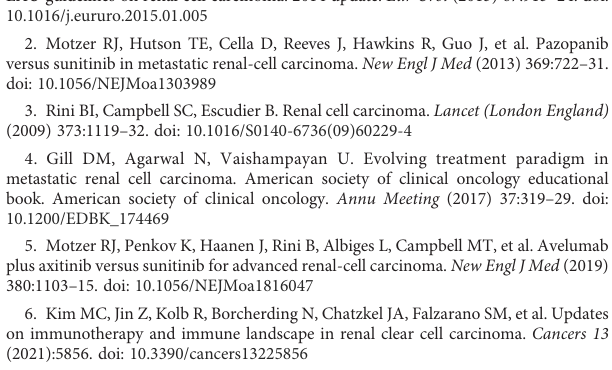
SUPPLEMENTARY FIGURE 2 The protein expression levels of the IRF family members between ccRCC samples and normal samples based on CPTAC using UALCAN database. SUPPLEMENTARY FIGURE 3 Prognostic value of the IRF family members in ccRCC in the TCGA- KIRC dataset. SUPPLEMENTARY FIGURE 4 The correlation between the IRF family members and clinical stage/ histological grade. SUPPLEMENTARY FIGURE 5 Prognostic and diagnostic values of the IRF family members in ccRCC. (A, B) Univariate and multivariate Cox regression analyses showed that IRF9 was an independent prognostic indicator in the TCGA-KIRC dataset. (C) ROC curve of IRF9 in evaluating diagnostic value for ccRCC. (D) ROC curve of IRF9 in predicting the 1-, 3- and 5-year OS. SUPPLEMENTARY FIGURE 6 The distribution of clinical characteristics between the two molecular